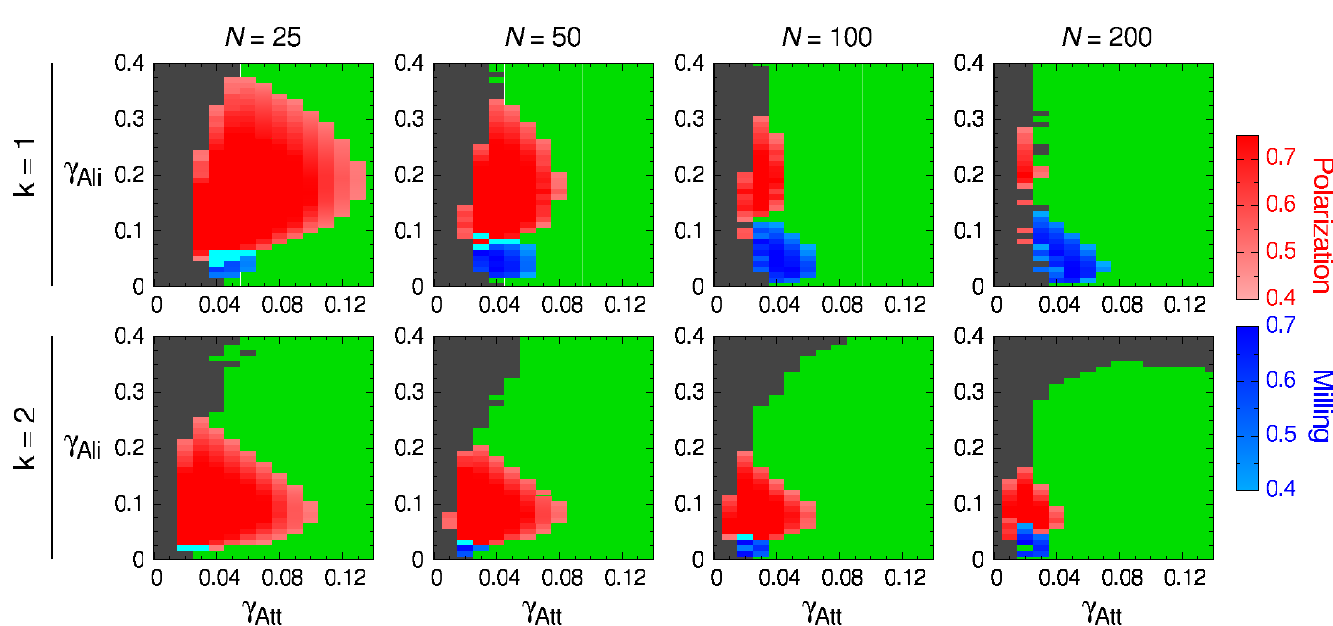
Fig 8. Phase diagrams for k = 1 and k = 2 and different group sizes. S CHOOLING ( P > 0.4, in red), M ILLING ( M > 0.4, in blue) and S WARMING (green) phases. Cyan regions correspond to P > 0.4 and M > 0.4, and gray region to high dispersion ( D > 7 m). Group sizes are, from left to right, N = 25, 50, 100, and 200 fish. First row: k = 1, second row: k = 2. We used l Att = l Ali = 0.28 m and γ R = 0.2, as for Figs 3 to 6.